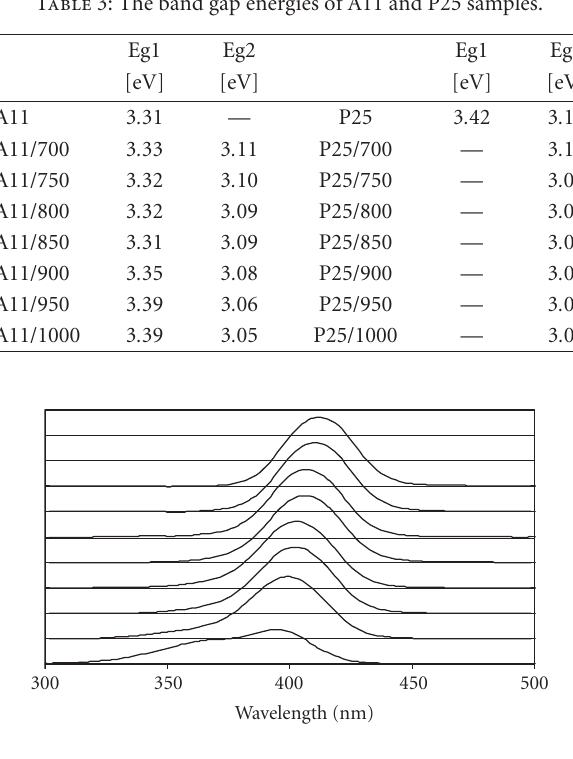
Figure 4: Derivatives obtained from UV-Vis/DR spectra for P25 photocatalyst samples. From bottom to top: untreated P25, P25/ 700 ◦ C, P25/750 ◦ C, P25/800 ◦ C, P25/850 ◦ C, P25/900 ◦ C, P25/950 ◦ C, P25/1000 ◦ C.